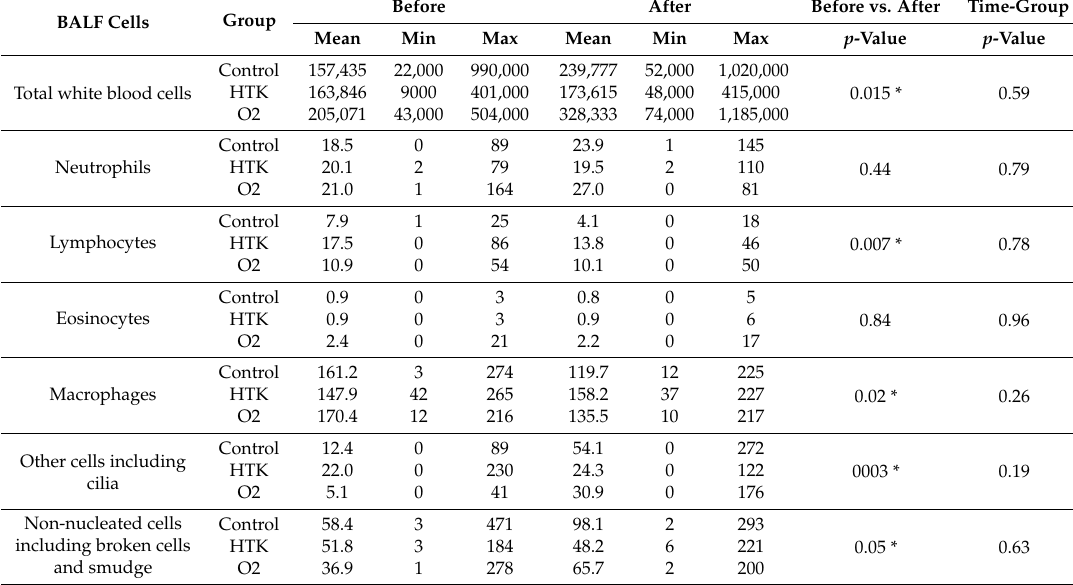
Table 3. Results of BALF cellular count in samples collected before and after CPB. Before After Before vs. BALF Cells Group